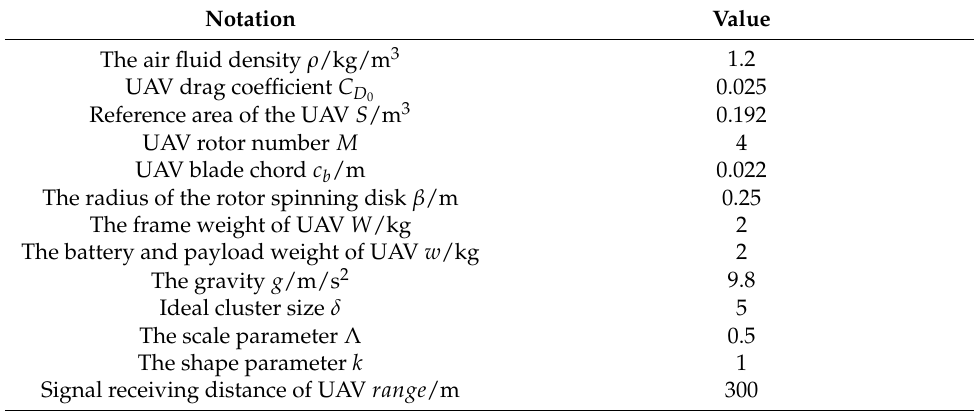
Table 2. Parameter